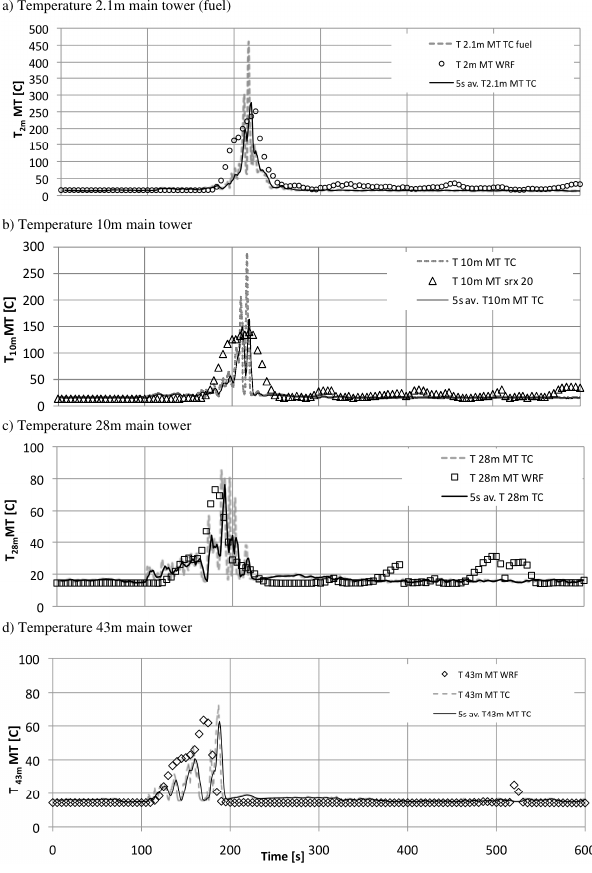
Fig. 5. Time series of the thermocouple air temperatures at the lo- cation of the MT at (a) 2.1m, (b) 10m, (c) 28m, and (d) 43ma.g.l. Gray lines show 1Hz measurements, black lines 5s averaged val- ues, symbols (open circles, triangles, squares, and diamonds) model